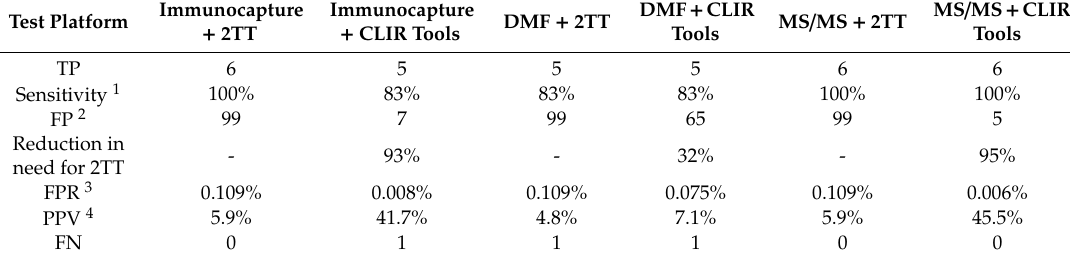
Table 7. Comparison of screening results without and with CLIR for Pompe disease using di ff erent assay platforms and 2nd tier testing. The basis for this comparison is the population used for CLIR analysis ( n = 87,321) and shows that the application of CLIR reduces the need for 2nd tier tests and improves the screening performance, except for the immunocapture method, where it leads to lower sensitivity.